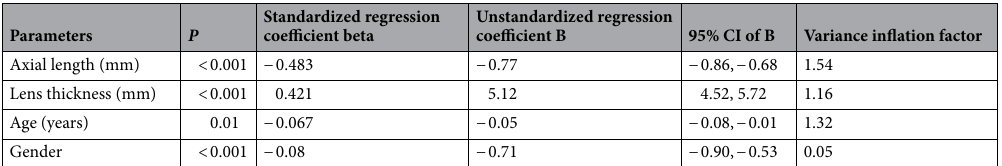
Table 5. Multivariate linear regression analysis of associations between refractive lens power and ocular and systemic parameters in the Qinghai Children Eye Study.